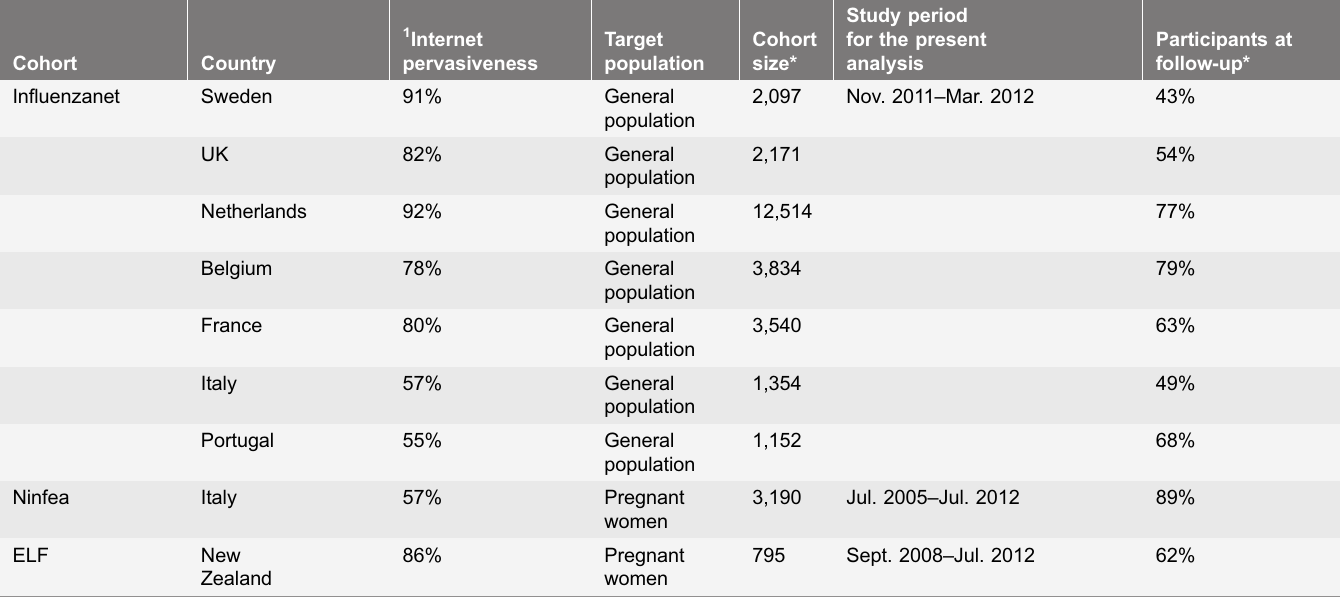
Table 1. Data summary by cohort and